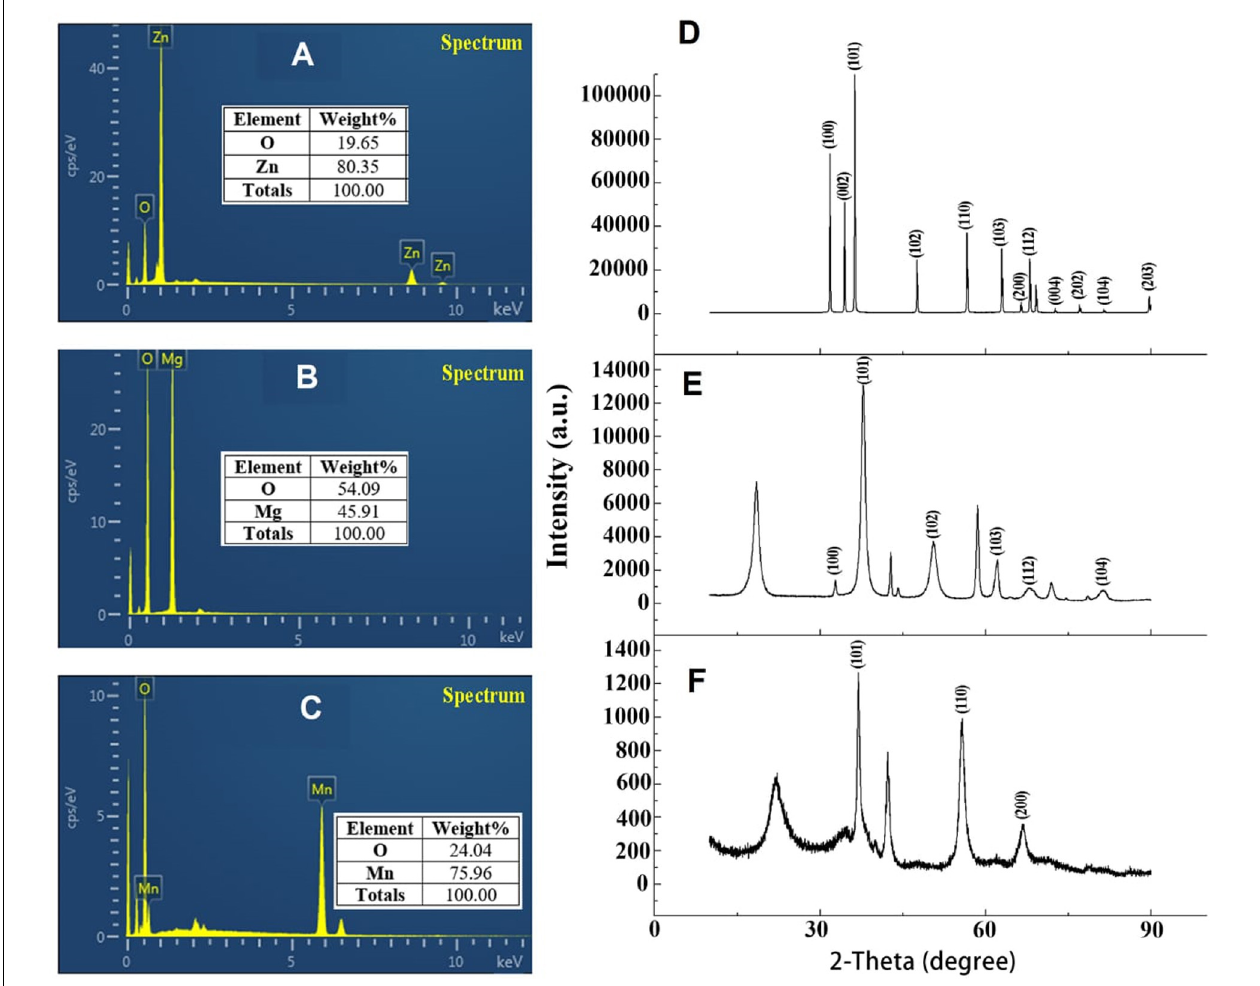
FIGURE 3 | Energy dispersive spectrum profiles of (A) ZnO nanoparticles (B) MgO nanoparticles (C) MnO 2 nanoparticles and X-ray Diffractometer spectra of (D) ZnO nanoparticles (E) MgO nanoparticles (F) MnO 2